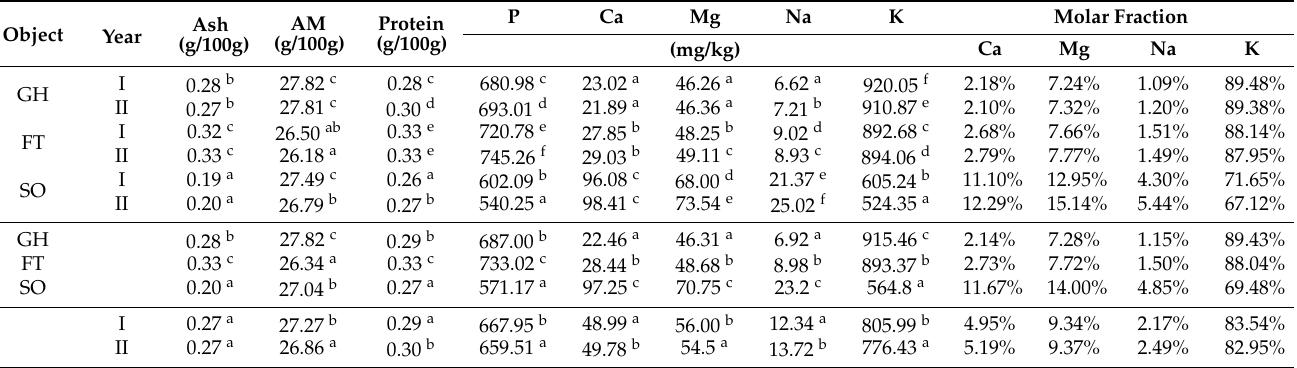
Table 1. Chemical composition of potato